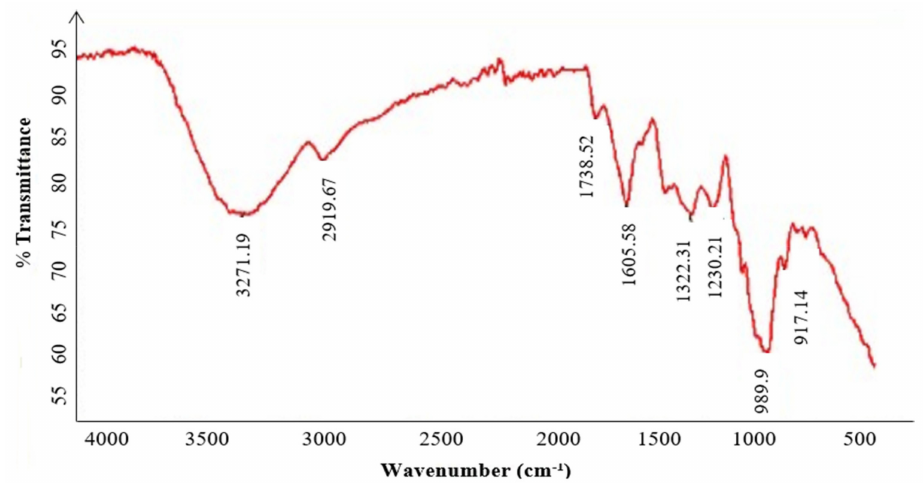
Figure 4. FT-IR spectrometric analysis of KWSP.